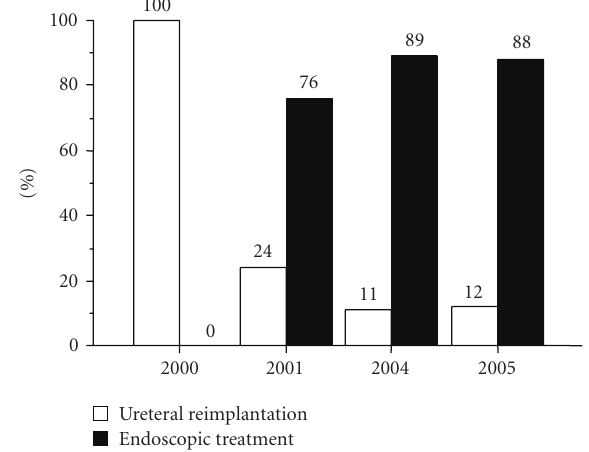
Figure 1: Trend of surgical treatment for VUR at Children’s Healthcare of Atlanta from 2000 to